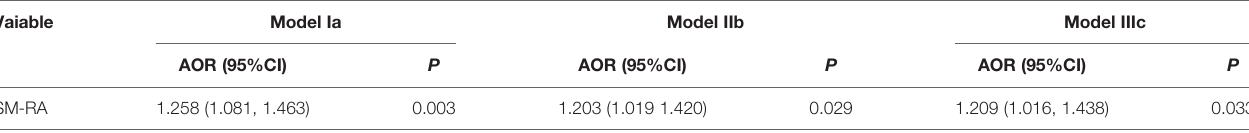
SM-RA, Skeletal muscle radiation attenuation; HAIC, hepatic artery infusion chemotherapy; AOR, adjusted odd ratio; CI, con fi dence interval; VFmean, Mean CT value of visceral fat. a Adjusted for gender and age. b Additionally adjusted for hemoglobin and Serum creatinine. c Additionally adjusted for VFmean.